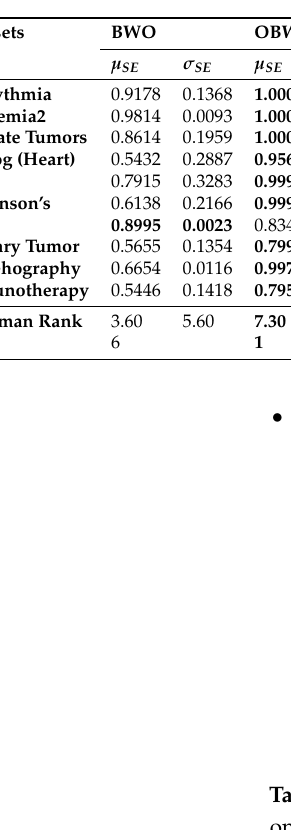
Table 10. Comparison of the sensitivity between OBWOD and other optimization algorithms based on the kNN classifier.